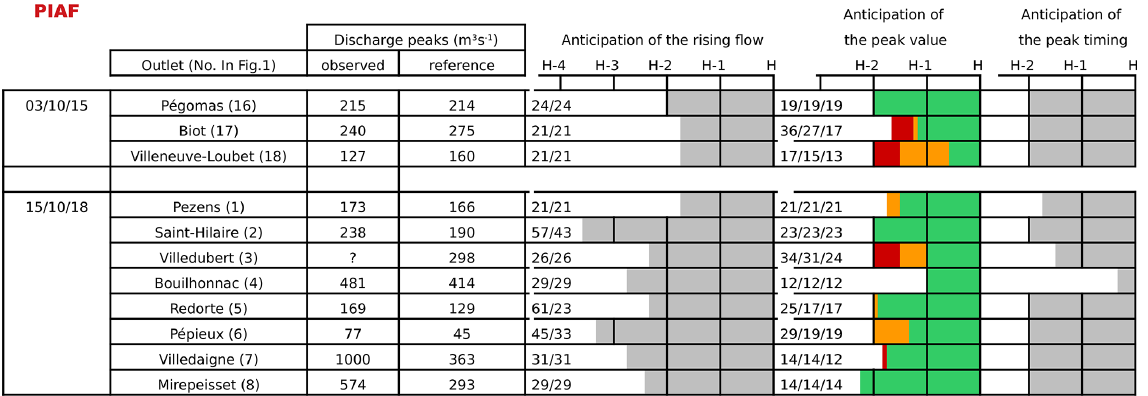
Table 5. Best anticipation of the rise in flow, peak value and peak timing simulated with ISBA-TOP driven by the PIAF rainfall forecast for the watersheds affected during the events of October 2015 and 2018. The green colour (respectively orange, red) indicates an intensity error on the forecast peak lower than 10% (respectively 20%, 30%) compared to the reference peak. Streamflow observations which were provided by the French HYDRO data bank (http://www.hydro.eaufrance.fr/, last access: 11 March 2020) or by HyMeX post-event surveys are for information purposes only. For more explanation on how to read the table, see Sect.